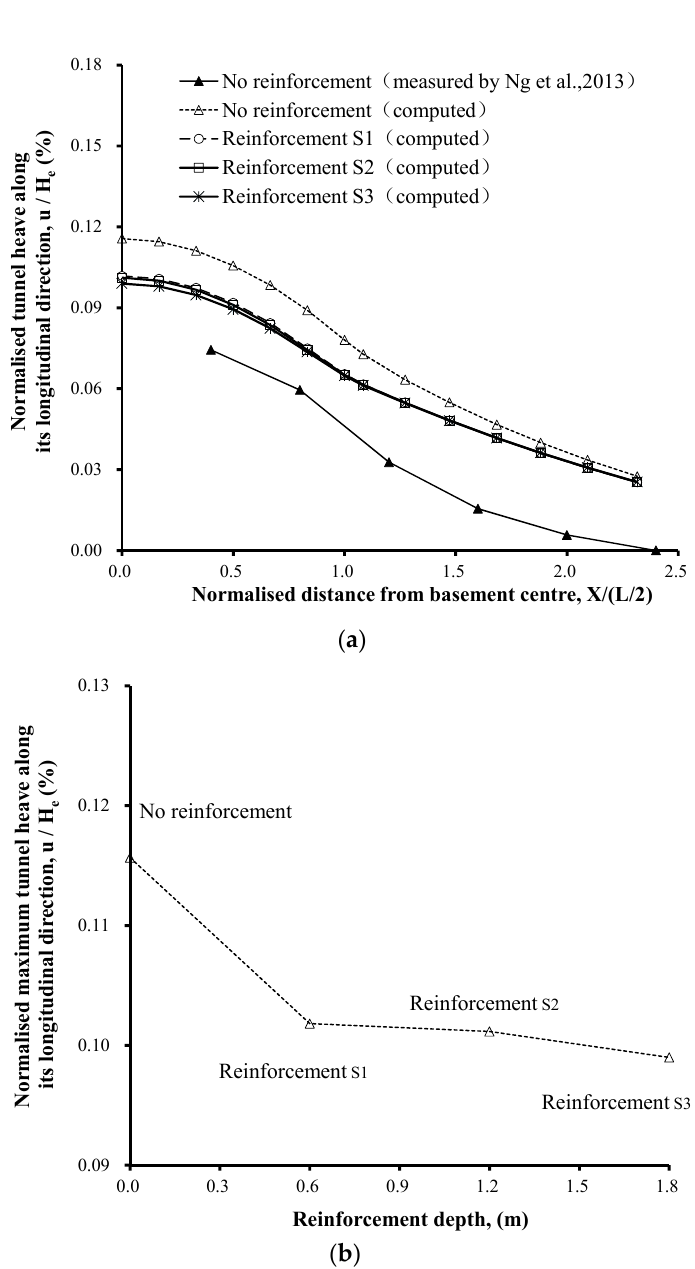
Figure 8. Measured and computed ( a ) tunnel heave and ( b ) maximum tunnel heave with different reinforced soil areas.